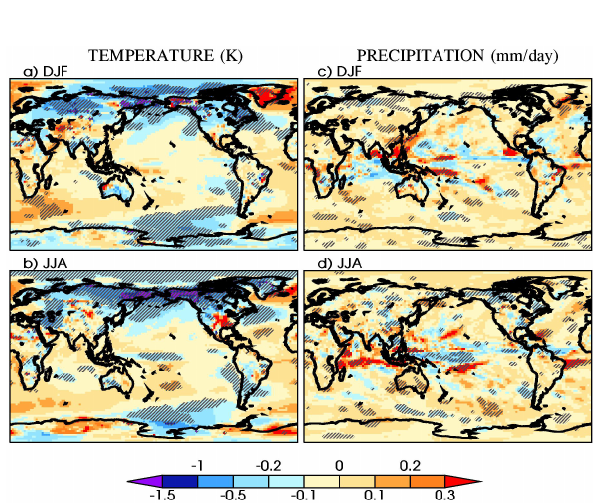
Fig. 4. Mean differences between LCC and control simulations for surface Temperature ( ◦ C) in (a) winter (DJF), (b) summer (JJA), and precipitation (mmday − 1 ) in (c) winter (DJF), and (d) summer (JJA). Mean differences are obtained by averaging over the last 100- year. Hatched areas are regions where changes are statistically sig- nificant at the 95% confidence level. Significance level is estimated using a Student-t test with a sample of 100 annual means and stan- dard error corrected for temporal serial correlation (Zwiers and von